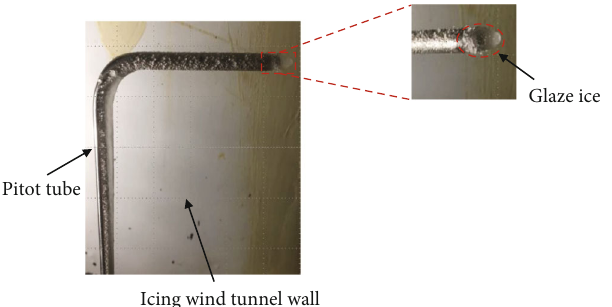
Figure 7: Pitot tube blocked by glaze ice.